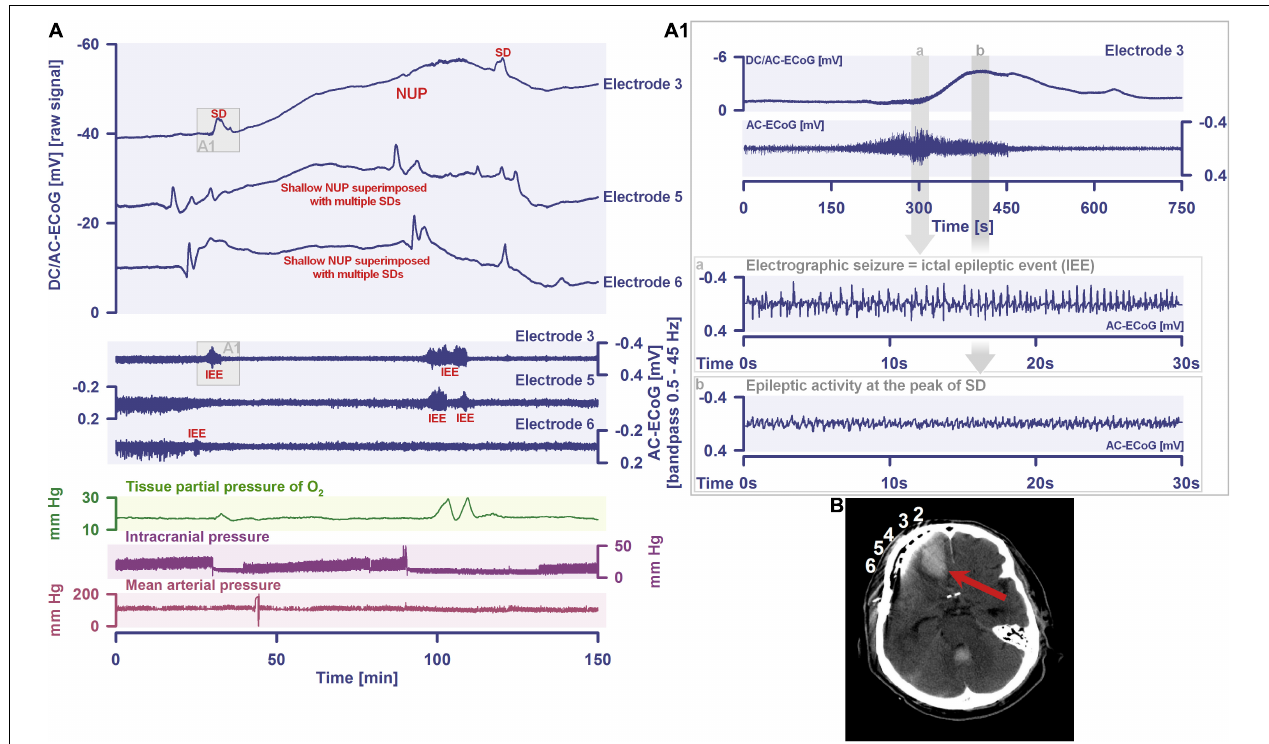
FIGURE 5 | (A) Spreading depolarization-initiated NUP superimposed with further SDs and IEEs recorded after aneurysmal subarachnoid hemorrhage (aSAH) in a 71-year old man (Dreier et al., 2012; Winkler et al., 2012). The NUP occurred on day 10 after the initial hemorrhage. Traces 1–3 from top to bottom give the DC/AC-ECoG recordings (band-pass: 0–45 Hz). The SD-initiated NUP and the later superimposed SDs are observed as negative DC shifts (negative upward). Traces 4–6 not only show the depressive effect of the SDs on the spontaneous brain activity but also the superimposed IEEs (AC-ECoG, band-pass: 0.5–45 Hz). Note that the first IEE at electrode 3 (trace 4) is temporally associated with the onset of an SD [shown at higher temporal resolution in the insert (A1) ]. Since the IEE is at least partially superimposed on the negative DC shift, it is a spreading convulsion according to the old nomenclature (van Harreveld and Stamm, 1953) or a spreading depolarization with epileptiform activity (SDEA) according to the new nomenclature. Trace 7 shows the tissue partial pressure of oxygen (p ti O 2 ) measured with an intraparenchymal sensor. Trace 8 gives the intracranial pressure (ICP) measured with an extraventricular drainage (EVD) catheter. Trace 9 shows the mean arterial pressure (MAP) measured with a radial artery catheter. The IEEs are associated with hyperoxic responses (the oxygen sensor was located in the cortex between electrodes 3 and 4). (B) Post-operative computed tomography (CT) scan showing an intracerebral hematoma (red arrow) in the right frontal lobe of the patient and electrodes 2–6 of the subdural recording